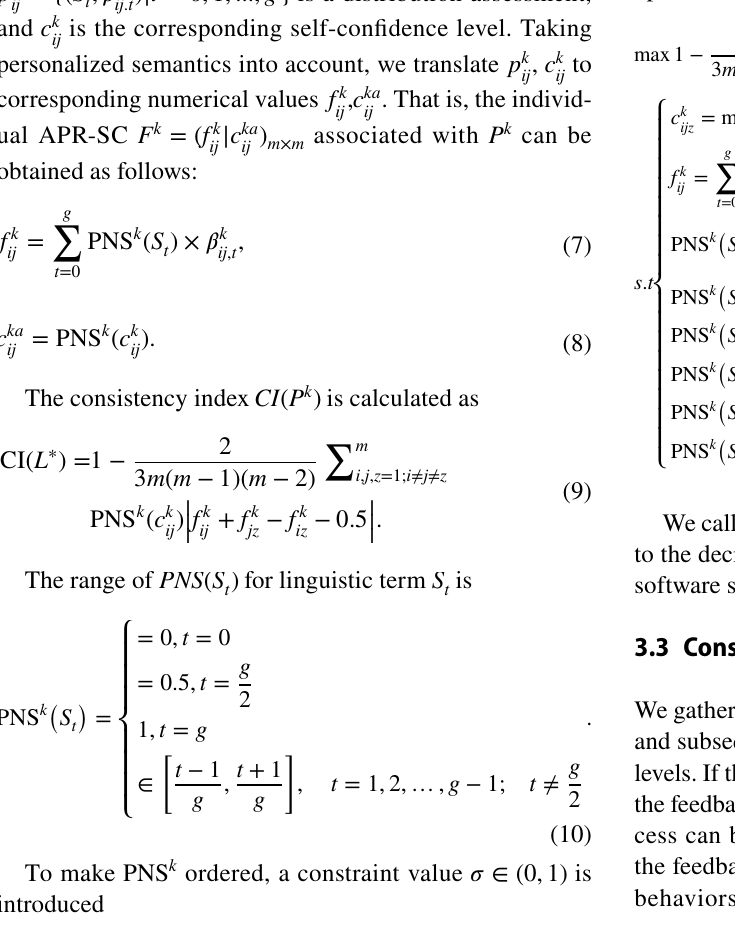
Fig. 1 Consensus framework Consensus measurement phase